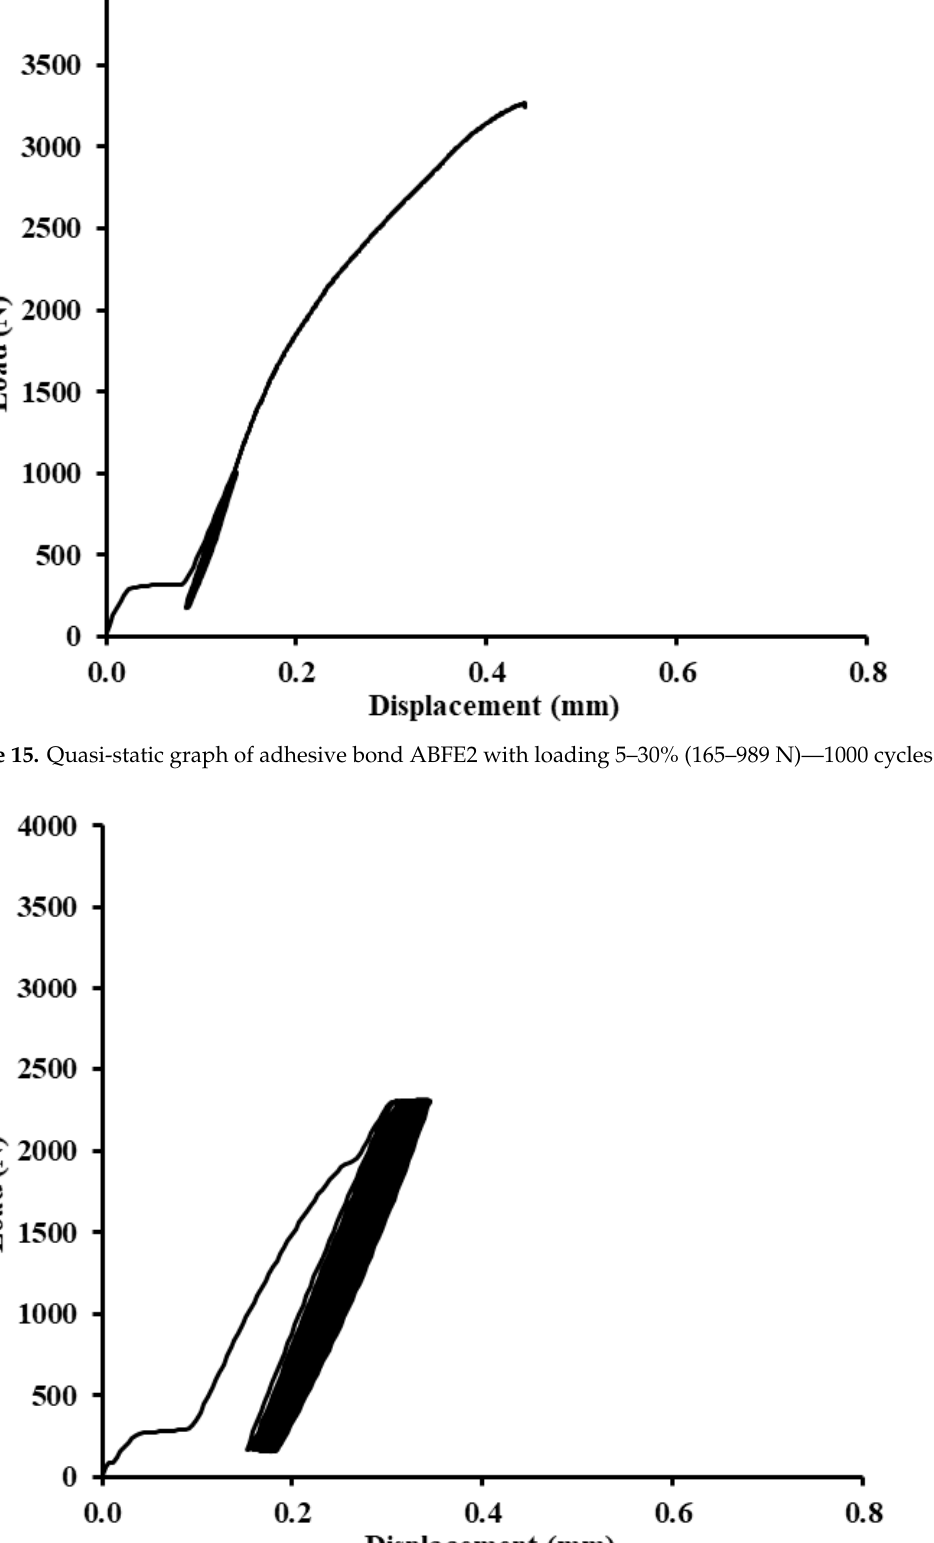
Figure 16. Quasi-static graph of adhesive bond ABFE2 with loading 5–70% (165–2307 N)—267 cycles.